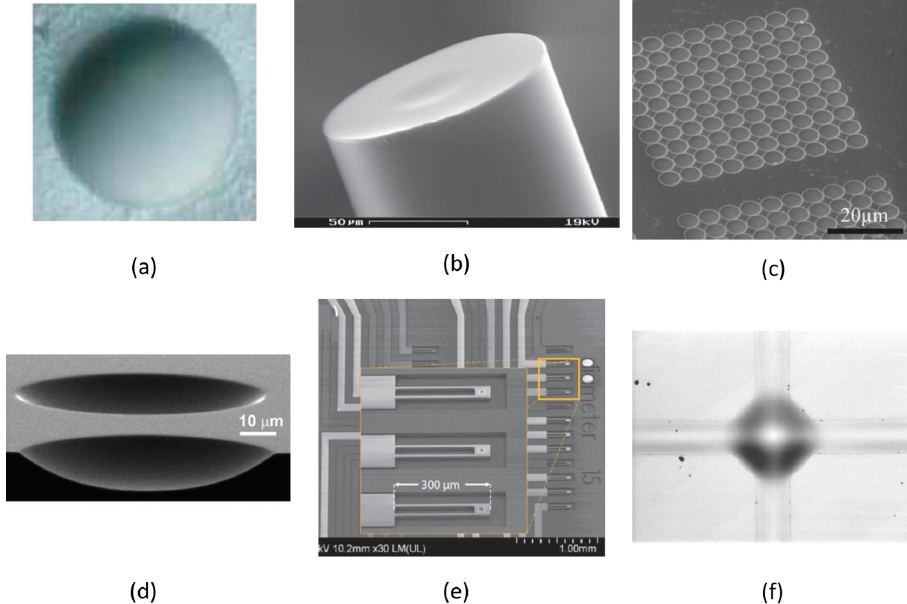
Figure 5. Microscope images of ( a ) a dimple with diameter of 200 μ m formed by a bubble-trapping method [76]; ( b ) a laser machined fiber end facet [12]; ( c ) array of concave features made by FIB milling [11]; ( d ) two silicon micro-mirrors fabricated by dry etching [78]; ( e ) array of cantilever based micro-